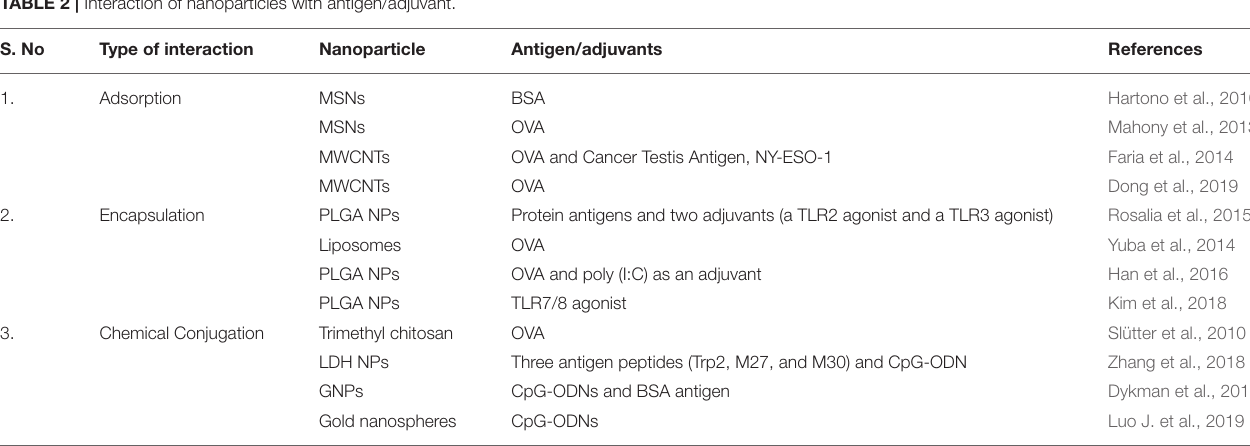
TABLE 2 | Interaction of nanoparticles with